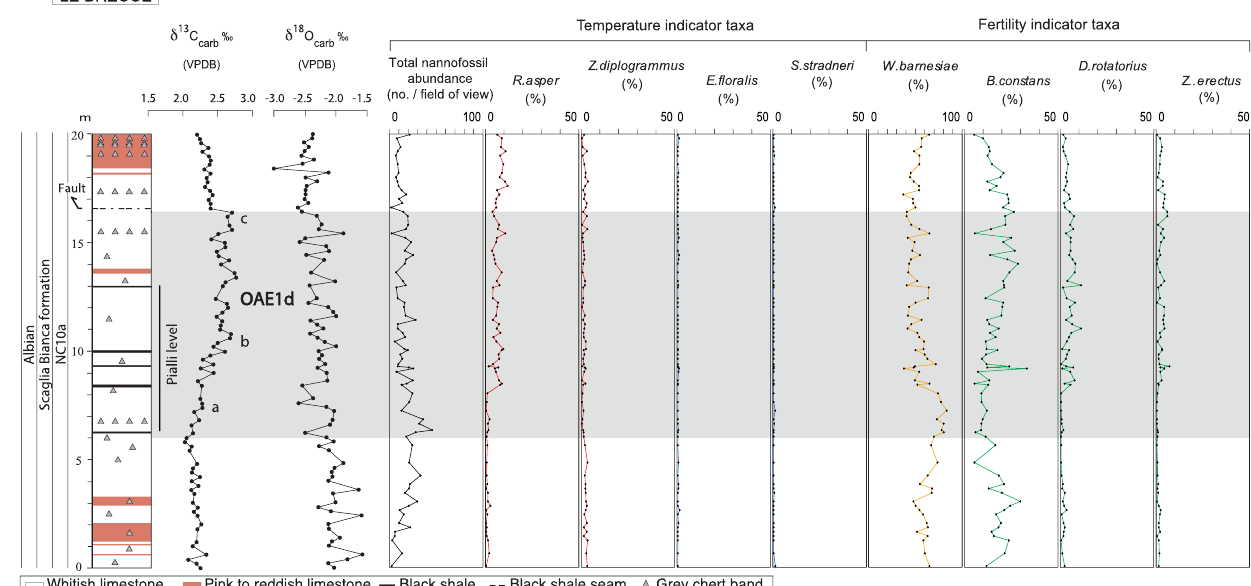
Figure 3. Le Brecce: total calcareous nannofossil abundance (average number of specimens in one field of view), relative abundance (%) of temperature and fertility indicator nannofossil species. The OAE 1d is indicated by a grey band. The stratigraphic framework (lithostratigra- phy, biostratigraphy, chemostratigraphy) is from Gambacorta et al. (2015).